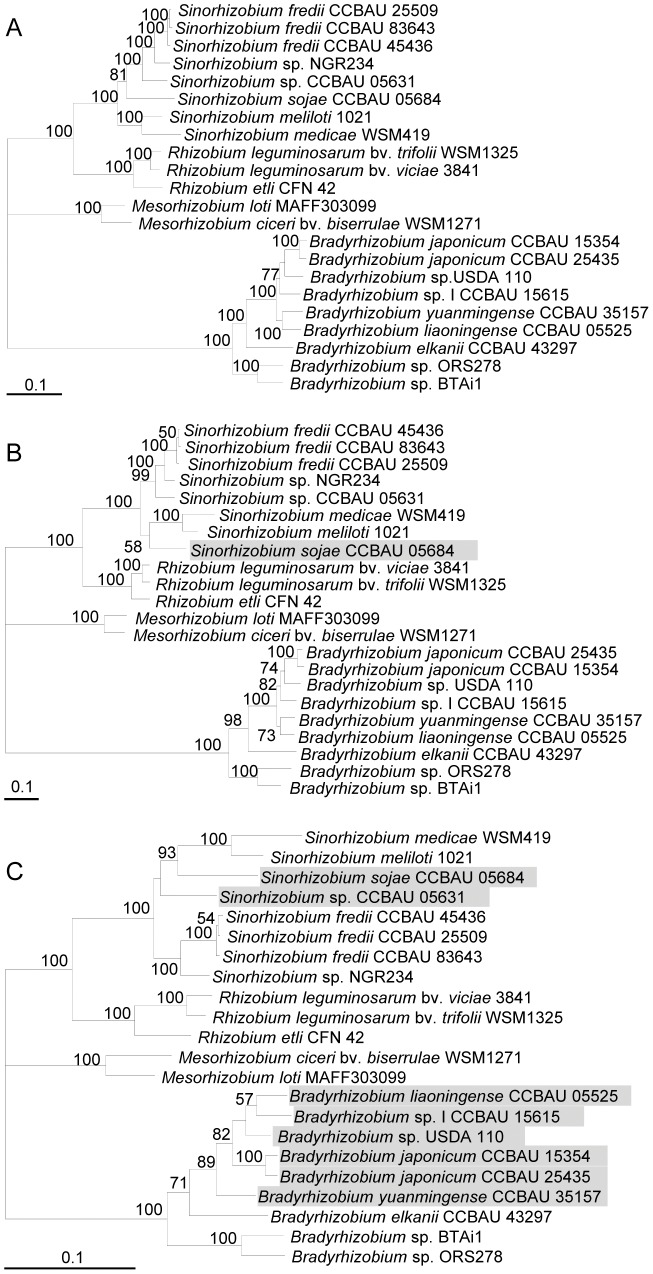
The maximum likelihood (ML) phylogenetic trees.The tree was constructed by PhyML based on concatenated sequences of 28 core genes (A), SMc00019-truA-thrA concatenate (B) or recA-glnII-atpD concatenate (C). Bootstrap confidence levels ≥50% are indicated at the internodes. Bar = 10% nucleotide divergence.